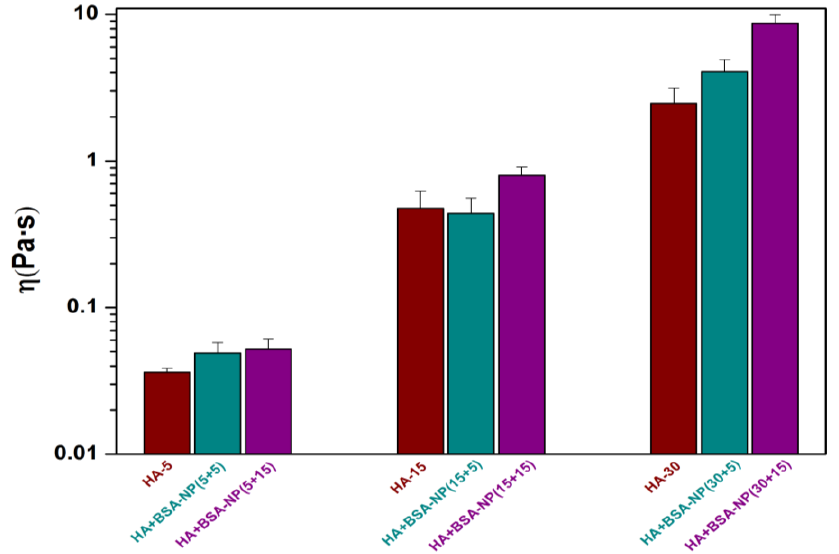
Figure 2. The viscosity of various fluids with different concentrations at a temperature of 25 ◦ C (shear rate: 0.001–10 s − 1 ): three concentrations (5 mg/mL, 15 mg/mL and 30 mg/mL) of HA were used and added with three different concentrations of BSA-NPs (0 mg/mL, 5 mg/mL and 15 mg/mL,